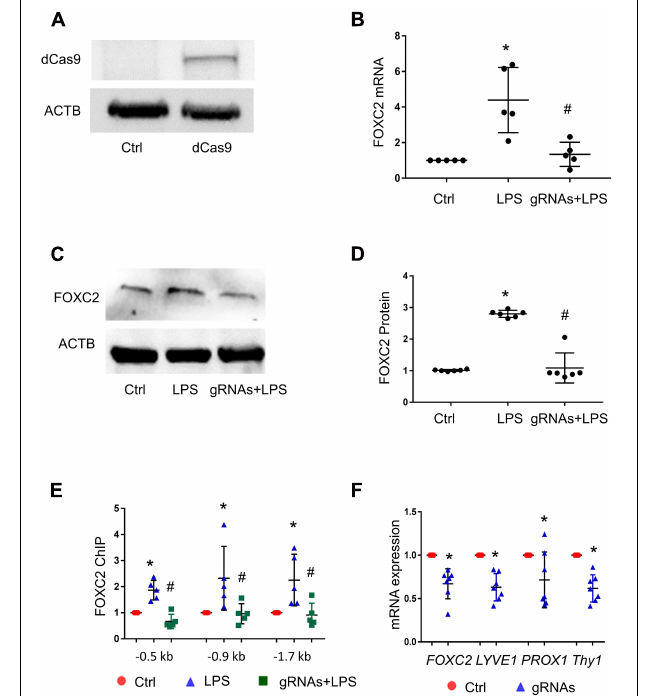
FIGURE 5 | LPS-induced FOXC2 autoregulation is histone acetylation dependent in mouse lung. (A) Mouse lungs were collected after 3 h LPS treatment, with or without different dosages of garcinol pretreatment (2 h). Protein expression of histone H3 and acetylated histone H3 was shown by immunoblotting. (B) Mouse lung EC were isolated after 3 h LPS treatment at P5, with or without 2 h garcinol pretreatment. FOXC2 protein in mouse lung EC was quantified by immunoblotting, with densitometry shown graphically (C) . n = 4 per group, * p < 0.0001, LPS vs. Ctrl; # p < 0.0001, Gar + LPS vs. LPS. (D) Mouse lung EC were isolated after 3 h LPS with or without garcinol co-treatment) at P7. ChIP with anti-FOXC2 antibody was performed with mouse lung EC. n ≥ 3 per group; * p < 0.05, ctrl vs. IgG; # p < 0.05, LPS vs. ctrl; ˆ p < 0.05, LPS + Gar vs. LPS. (E) Mouse lungs were cryopreserved at P7 after 24 h LPS treatment, with or without garcinol pre-treatment. FOXC2 (green) and PECAM (red) IF staining was applied. Lower panels present the magnified images in the boxes of the up panels. White arrows point to the EC (red) which express FOXC2 (green). n = 3–4 per group; scale bars: 10 µ m.